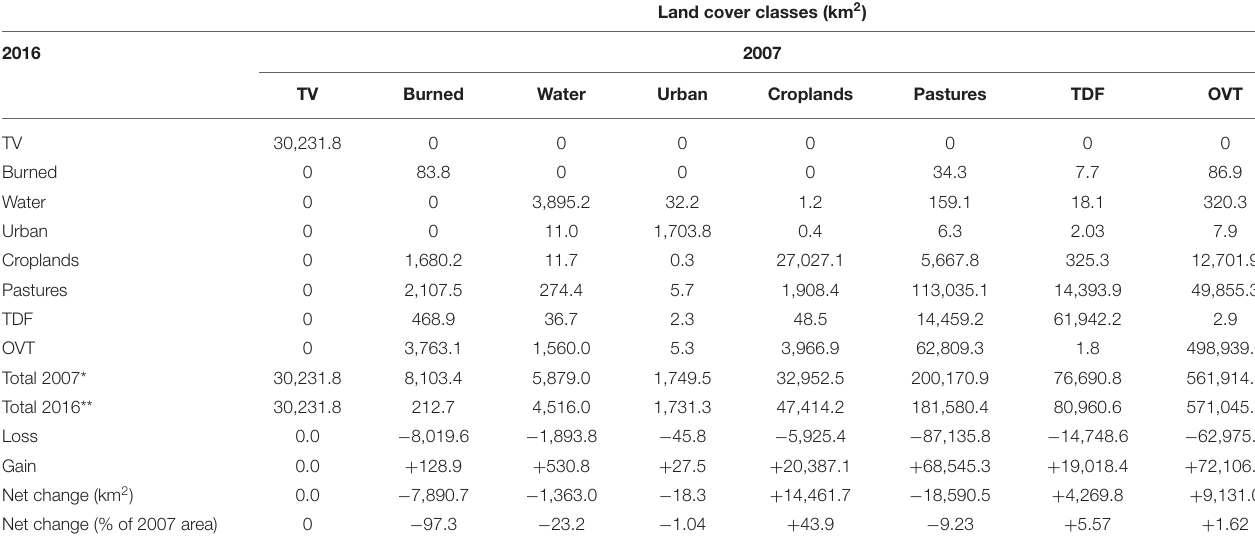
TABLE 1 | Changes among land cover classes in the studied TDF region from 2007 to 2016.